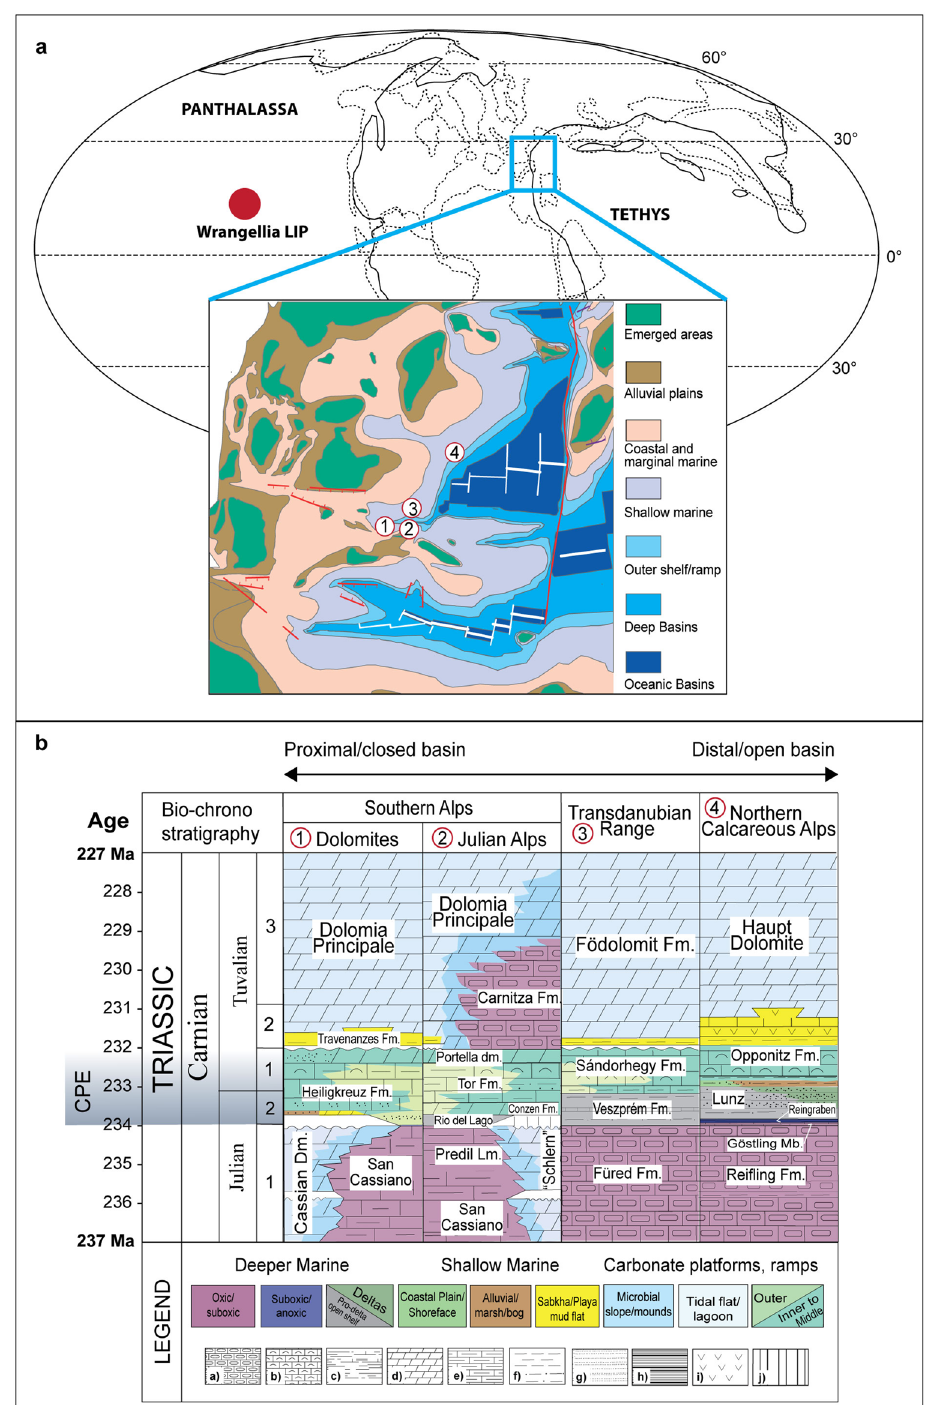
Figure 1. ( a ) Late Triassic palaeogeography and position of the studied successions in the Western Tethys (1 = Dolomites; 2 = Julian Alps; 3 = Transdanubian Range; 4 = Northern Calcareous Alps); the map is modified using QGIS (version 3.20.1, https:// qgis. org/ en) after ref. 14 , ( b ) Lithostratigraphic scheme for the Carnian formations in the studied areas. Julian 1 = Trachyceras zone, Julian 2 = Austrotrachyceras austriacum zone; Tuvalian 1 = Tropites dilleri zone , Tuvalian 2 = Tropites subbullatus zone , Tuvalian 3 = Anatropites spinosus zone. Lithology: a = Cherty limestone, b = Bioclastic limestone, c = Limy marlstone, d = Dolomite, e = Marly limestone, f = Siltstone, g = Sandstone, h = Black shale, i = Evaporites, j =